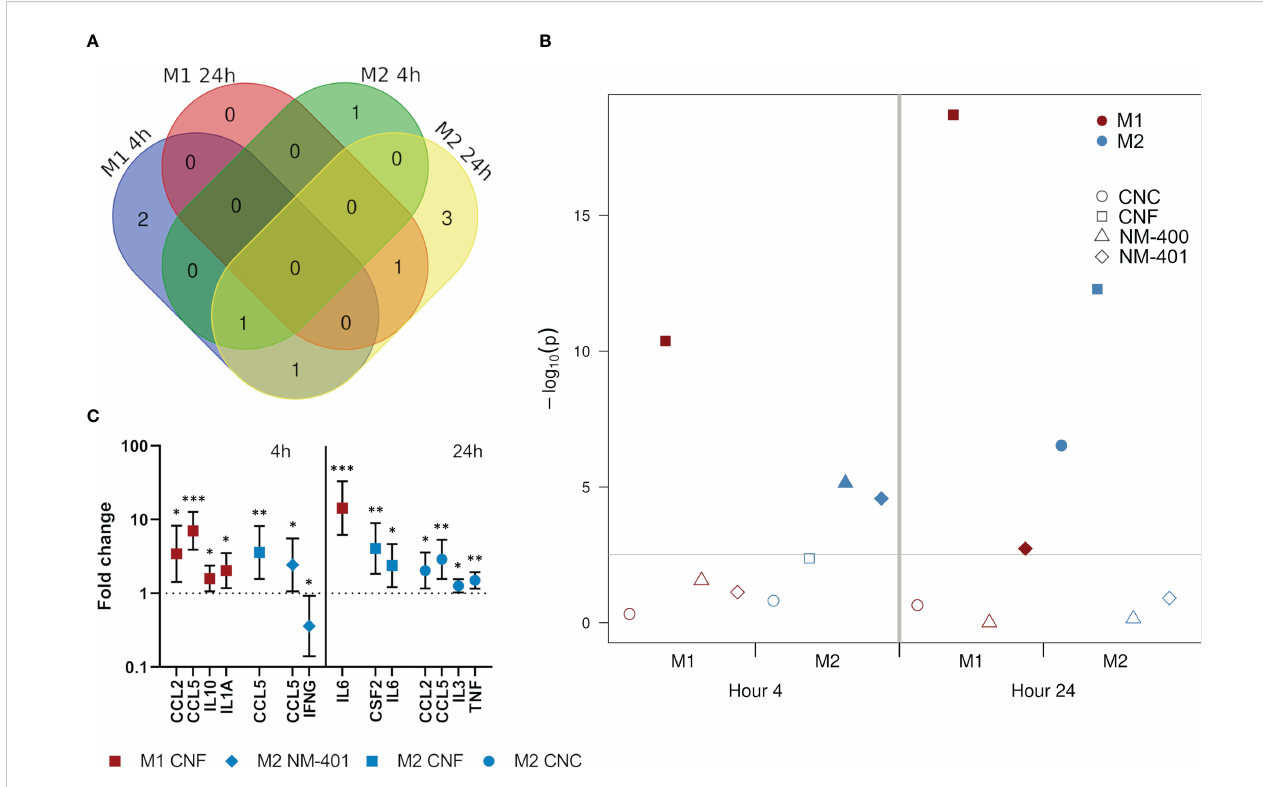
FIGURE 4 Effects on the secretion of cytokines and chemokines following exposure to CNC, CNF, NM-400 and NM-401 (high C2 dose). (A) Venn diagram illustrates the temporal differences in affected cytokines and chemokines in exposed M1 and M2 cells. (B) The combined in fl ammatory potential of nanomaterial exposure was illustrated by the p − values ( − log 10 ) of treatment effects for the deregulated proteins. The cutoff line indicates the signi fi cance level corrected for multiple testing. Filled symbols indicate values above the cutoff line where the exposure signi fi cantly affected the total secretion of cytokines in the speci fi ed macrophage subclass. (C) Cytokines and chemokines with signi fi cant changes in their secretion in M1 cells and M2 cells at 4 and 24h of exposure compared to controls. Data indicate mean ± CI, (n=4), *p<0.05, **p<0.01,